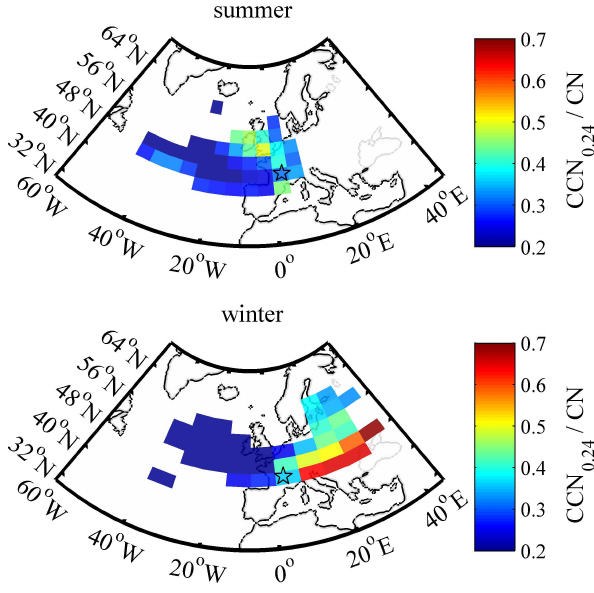
Fig. 7. Hygroscopicity parameter κ value with the air mass ori- gin during summer (up) and winter (down). The star marks the location of the measurement site. For details of the calculations, see Sect. 3.3: aerosol CCN properties by air masses. Note that the colour scale is different for summer and winter.